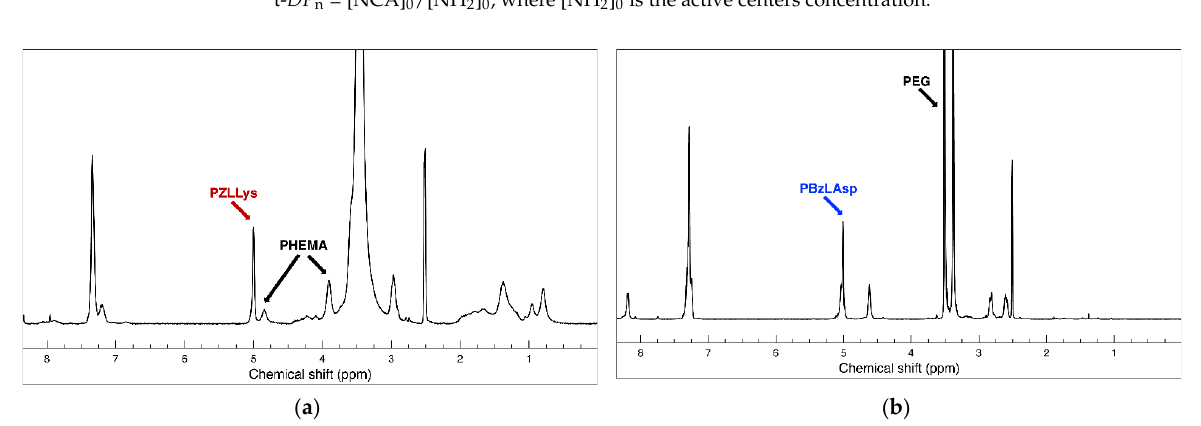
Figure 1. 1 H NMR (600 MHz) spectra in DMSO-d 6 of ( a ) protected polycationic hybrid diblock copolymer PHEMA- b -PZLLys; ( b ) protected polyanionic hybrid diblock copolymer HO-PEG- b - PBzLAsp. Table 1. Molar mass characteristics of macroinitiators and the corresponding hybrid peptide- based diblock copolymers.